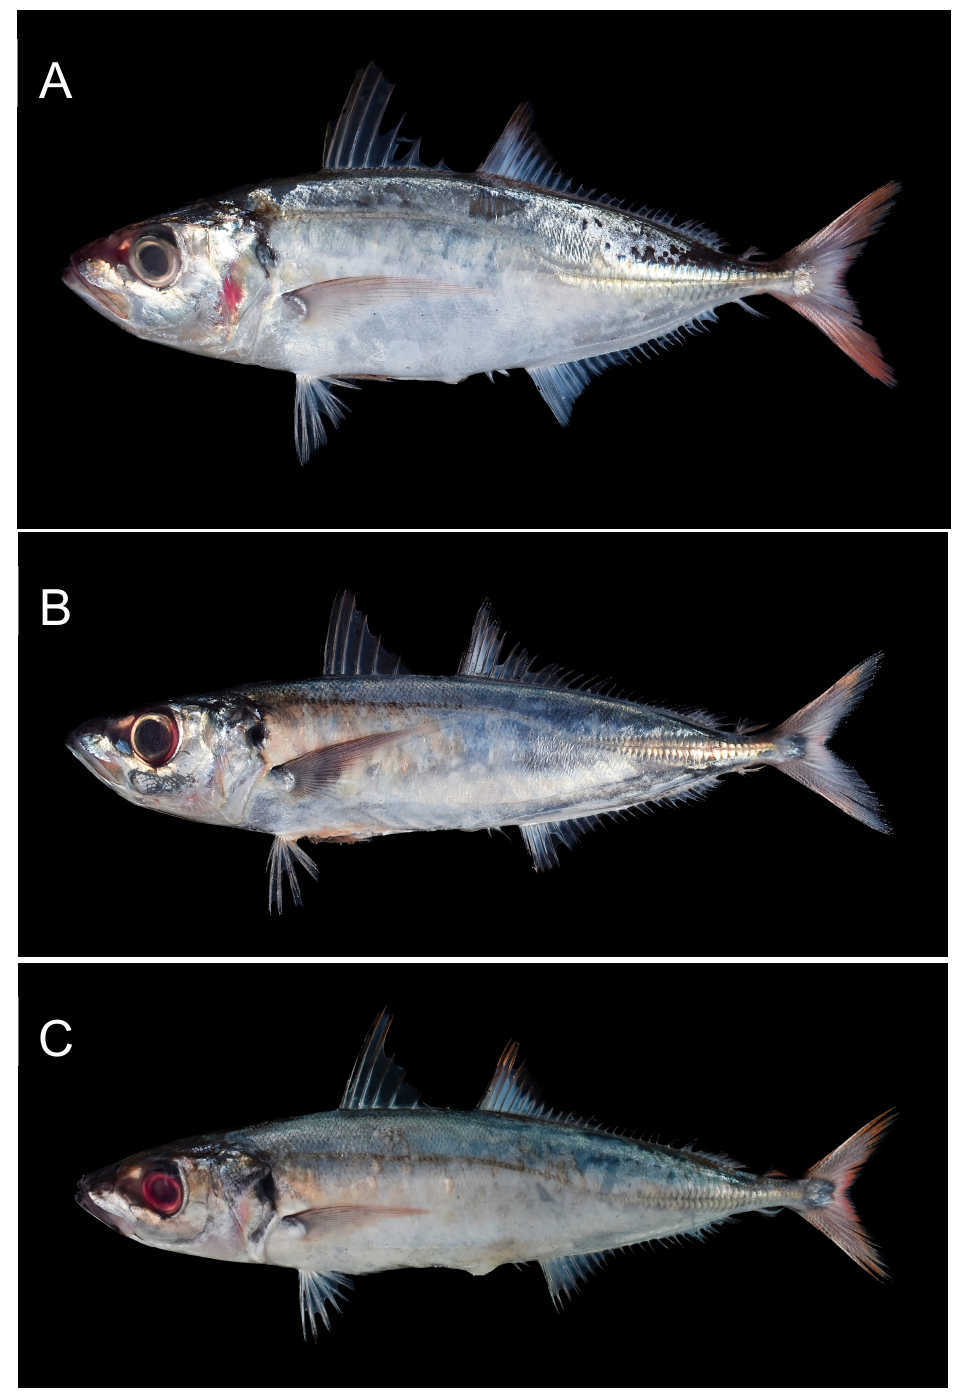
Figure 1. Representative images of the three redfin Decapterus species used in this study: ( A ) Decapterus kurroides; ( B ) D. smithvanizi; ( C ) D. tabl. Photos by E.S.D.J.